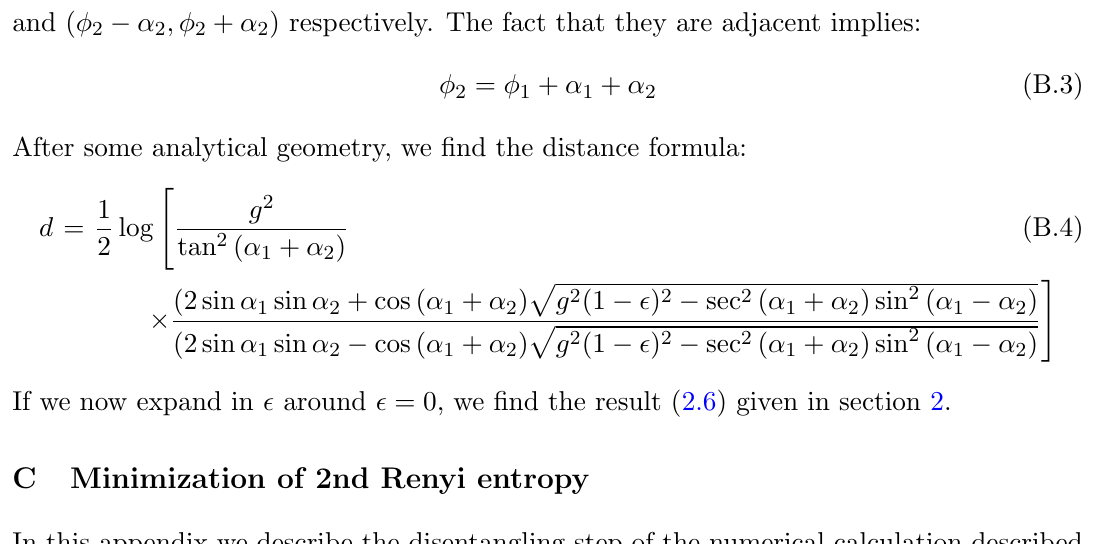
Figure 17. The RT surface for AB is in red. The EP surface for E regularizing surface is in black